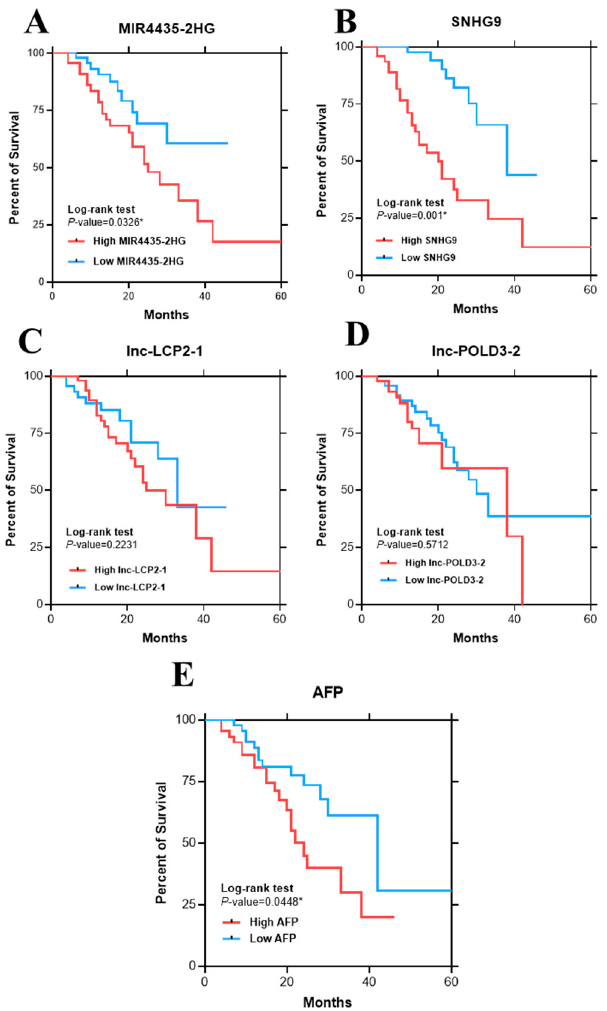
Figure 4. Kaplan–Meier survival curves for overall survival analysis of patients with HCC ( A ) MIR4435-2HG ( B ) SNHG9 ( C ) lnc-LCP2-1 ( D ) lnc-POLD3-2 ( E ) AFP.